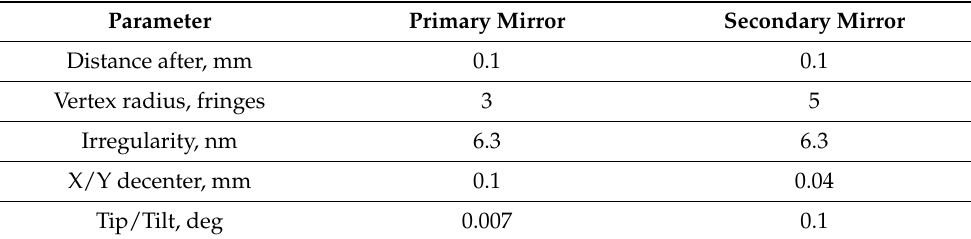
Table 1. Optical design parameter